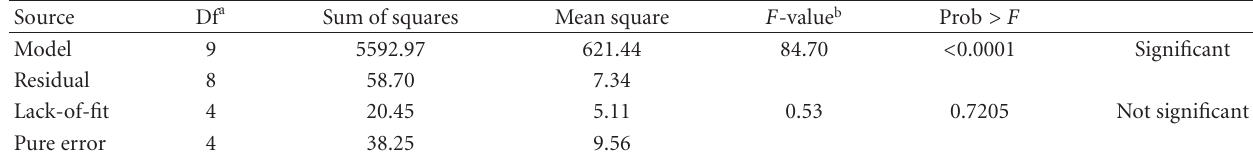
Table 4: Analysis of variance (ANOVA) of the response Y for